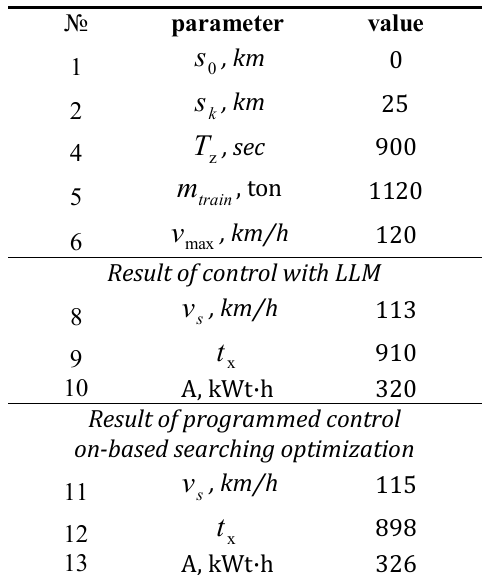
Table 2 . Result of